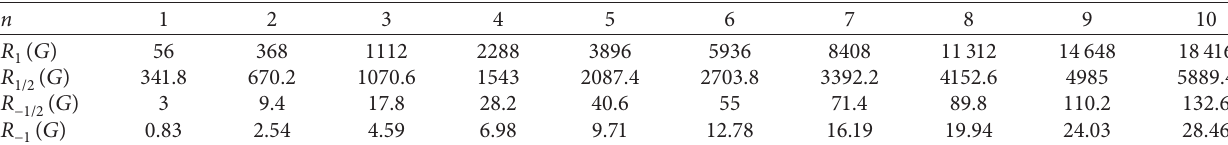
Table 3: Numerical comparison of Star of David